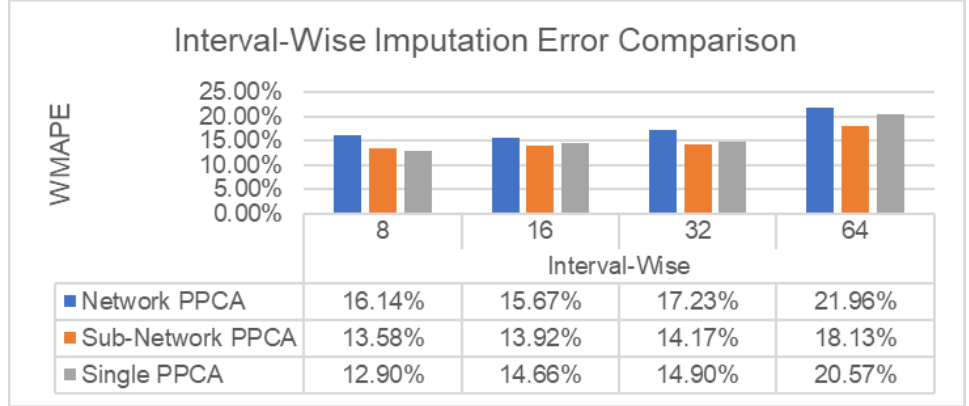
Figure 7. Imputation performance comparison for Network PPCA , Sub-Network PPCA , and Single PPCA for Scenario A with different interval-wise missing data intervals.